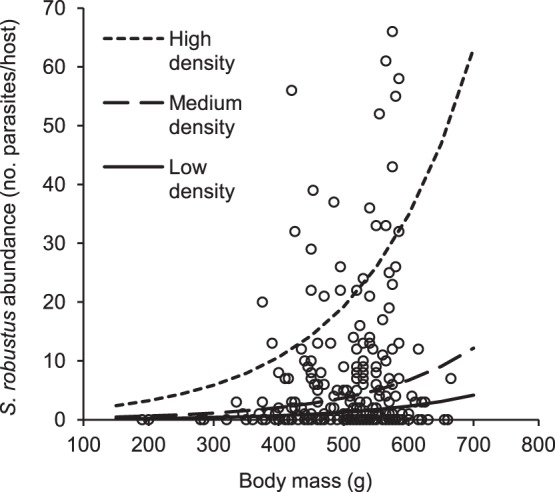
Variation of S. robustus abundance by host body mass.Relationship between S. robustus abundance and host body mass: observed values (blank circles) and values predicted by the model at different host densities (lines). Host body mass had a positive effect on S. robustus abundance (p = 0.0005; parameter estimate: 0.0059±0.0017 SE).